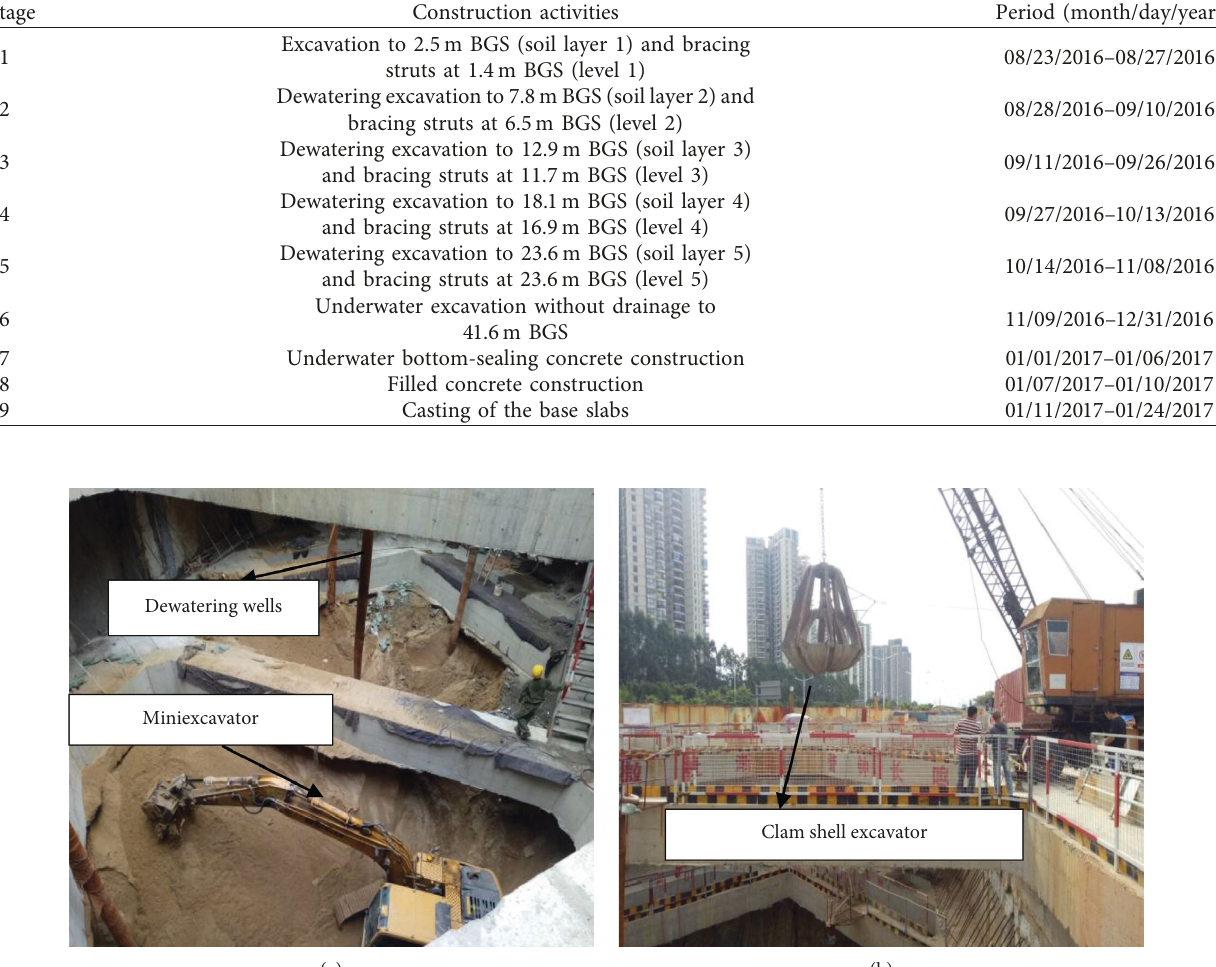
Table 2: Construction schedule for the excavation.